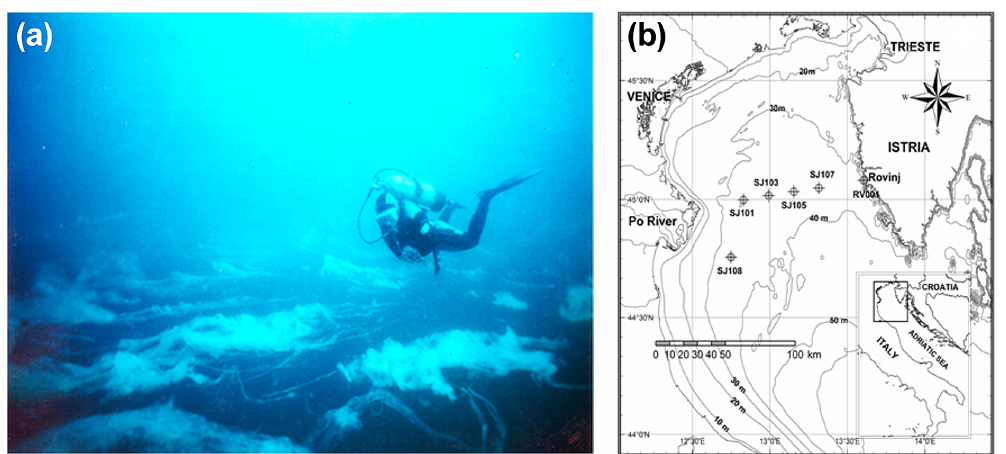
Figure 1. Macroaggregation phenomena in the northern Adriatic: (a) giant gel aggregate at 10m depth as captured by a scuba diver in August 1997 (courtesy of Gerald Müler-Niklas) and (b) map of the study area (inset) and sampling stations in the northern Adriatic.